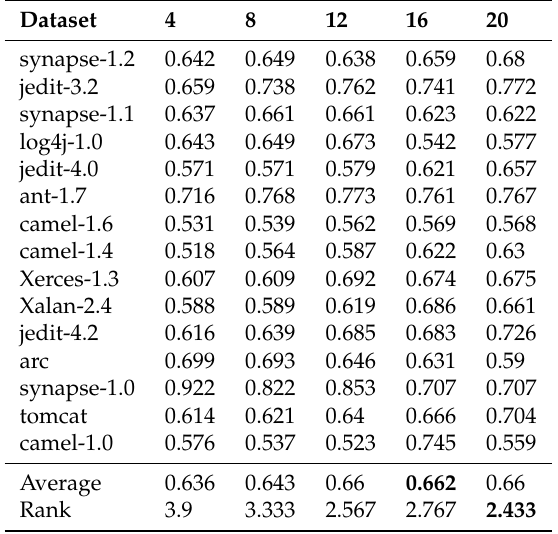
Table 14. Balancedscore of different number features in GNB with LIMCR on small